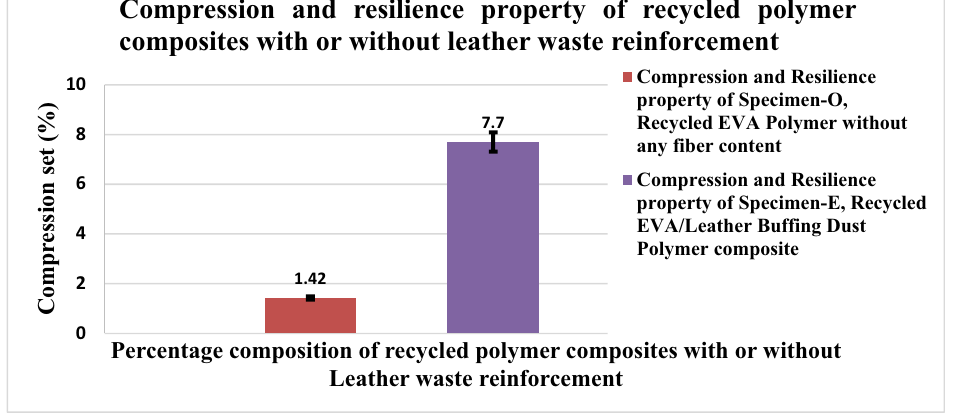
Figure 40: Comparison of compression and resilience ( % ) of recycled EVA polymer composites with or without leather bu ffi